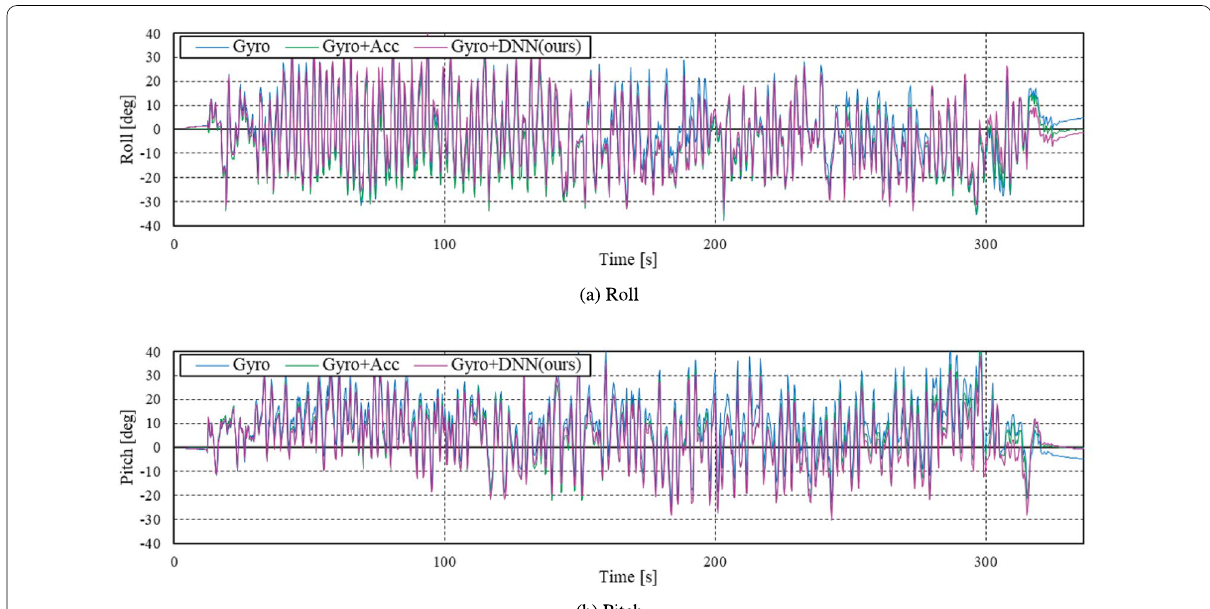
Fig. 15 Real-time plotting in outdoor experiment. Note that the ground truth while the sensors were being carried is not available in the outdoor